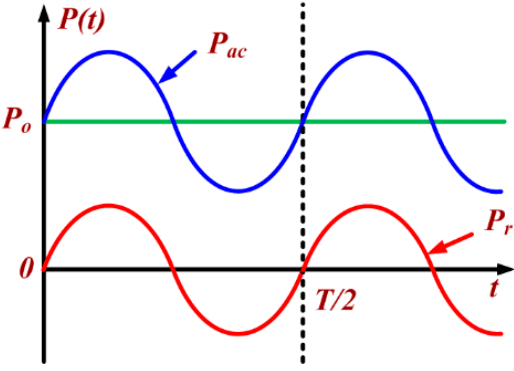
Figure 2. Output power and ripple power.